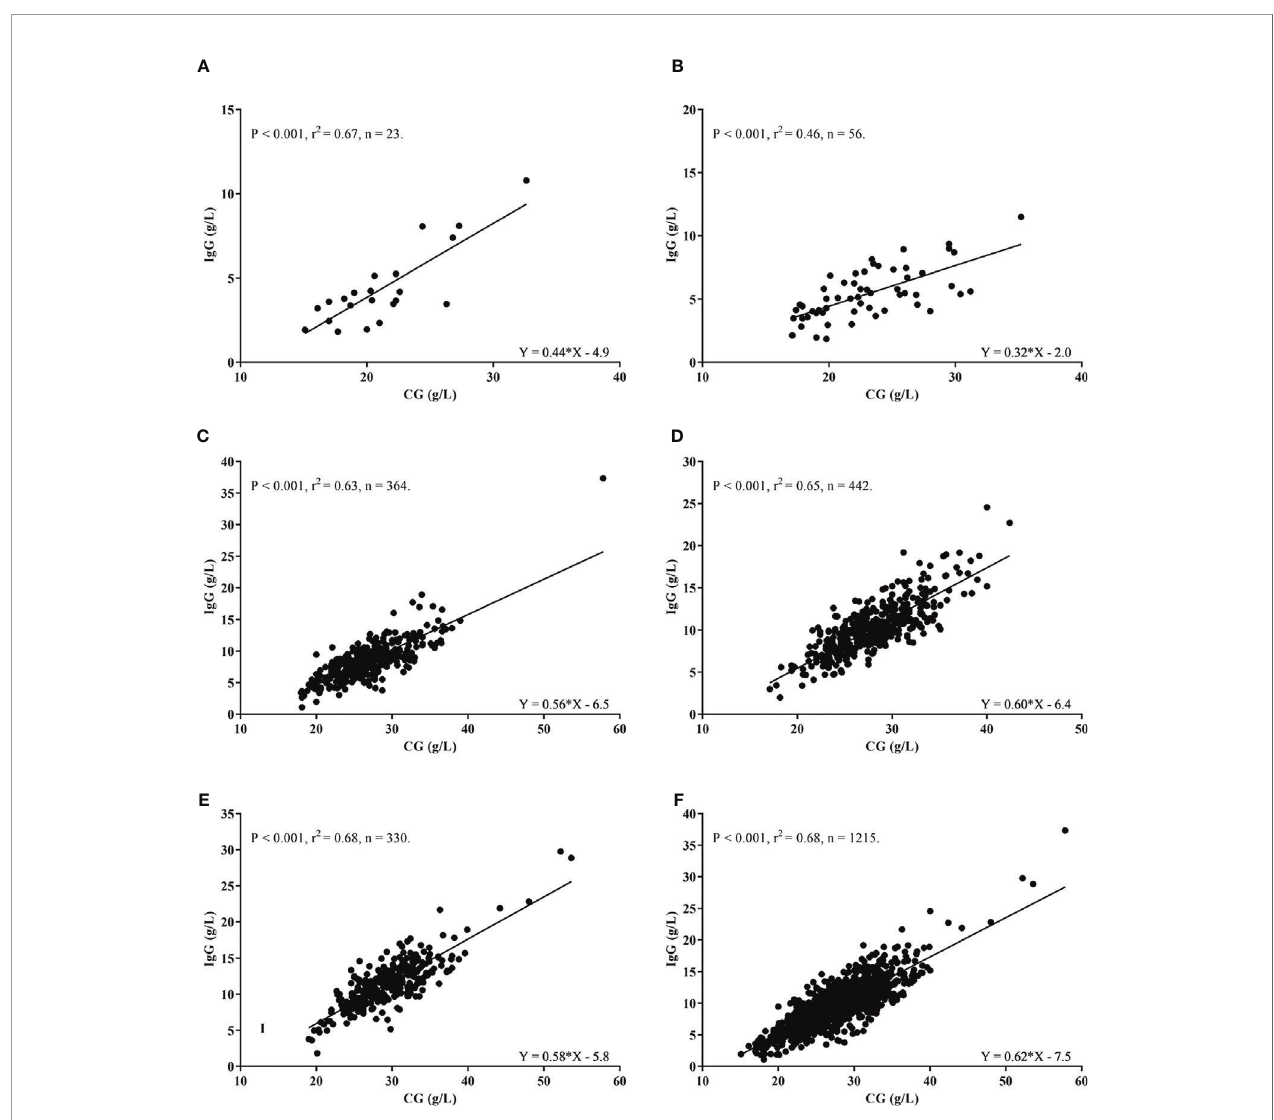
FIGURE 2 | Correlation between IgG (g/L) and Calculated Globulin values (g/L) according to age groups. (A) 1 to 5 months. (B) 6 to 11 months. (C) 1 to 3 years. (D) 4 to 9 years. (E) 10 to <18 years. (F) All age groups